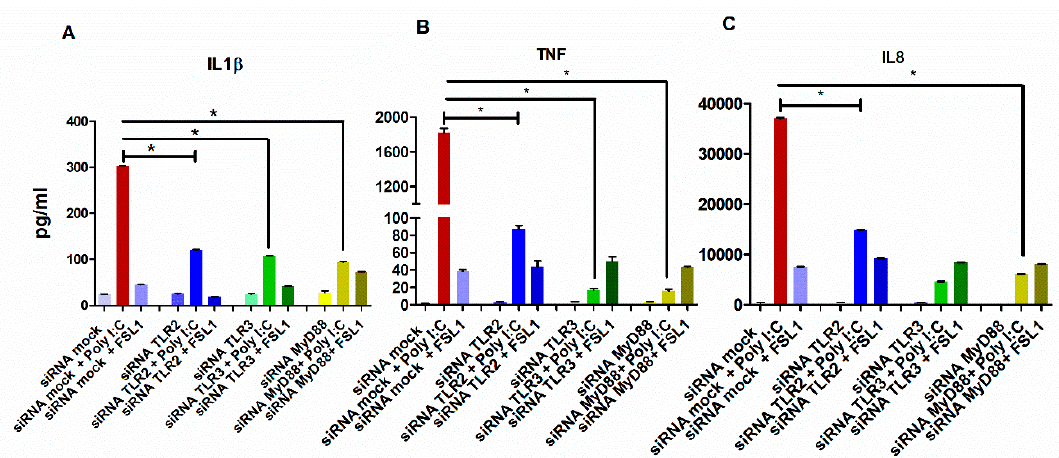
Figure 5. Poly I:C-upregulated cytokine production is partially through the activation of TLR2 and MyD88. The HGECs were stimulated with poly I:C and FSL1 for 24 h after silencing TLR2, TLR3 and MyD88. ELISA on the supernatant showed a significant decrease in IL1 β ( A ), TNF ( B ) and IL8 ( C ) levels. Moreover, TLR2 silencing significantly downregulated IL1 β , TNF and IL8 secretion upon poly I:C treatment. The striking difference was observed when MyD88 was silenced, where IL-1 β , TNF and IL8 secretion was significantly downregulated upon poly I:C treatment. These data underline the unexpected role of MyD88 in the MyD88-independent pathway. Statistical test: one-way ANOVA followed by Tukey’s multiple comparison test (* p < 0.05) and the results are represented as the mean ± SE ( n = 3) from three independent